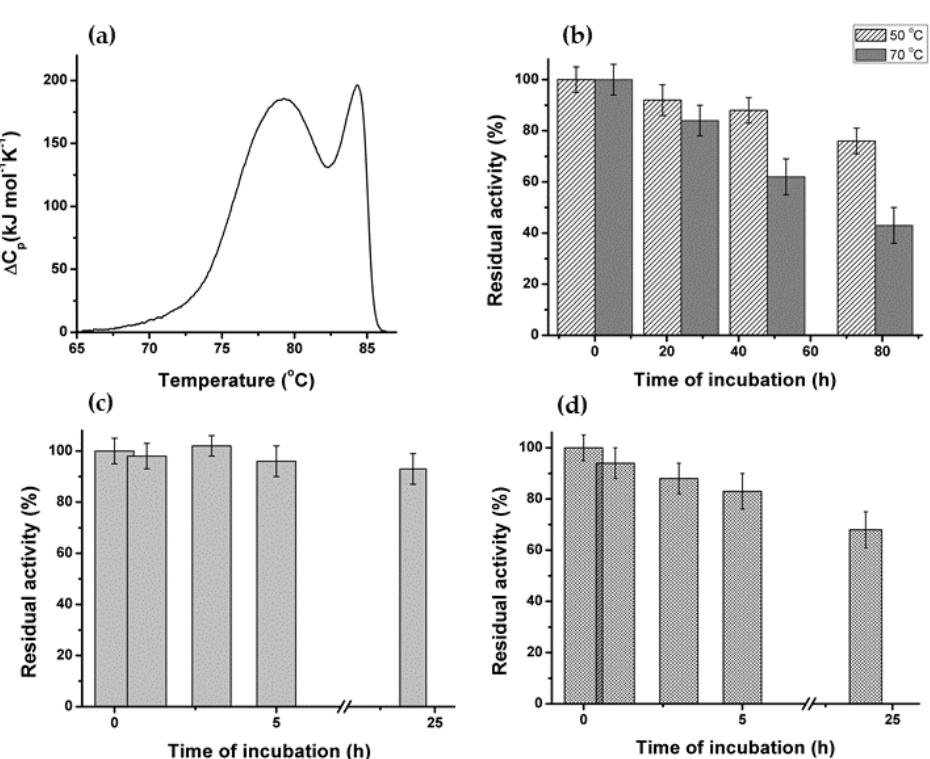
Figure 1. Thermal stability of TaTT . ( a ) Di ff erential scanning calorimetry (DSC) profile of 1.0 mg / mL TaTT. ( b )–( d ) Residual activity of TaTT after incubation ( b ) in bu ff er S (50 mM Tris-HCl, pH 8.0, containing 100 mM NaCl, 60 µ M PLP) at 50 ◦ C and 70 ◦ C; ( c ) in bu ff er S with 50% DMSO ( v / v ) at 50 ◦ C; ( d ) in bu ff er S with 50% ( v / v ) methanol at 50 ◦ C. 100% corresponds to 40 ± 4 U / mg in the standard assay. Error bars represent standard deviation.